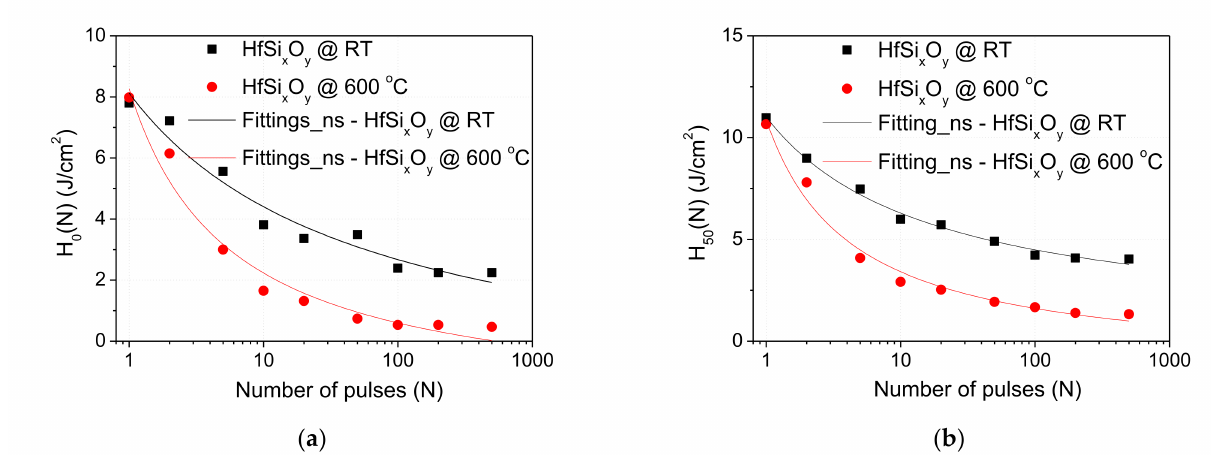
Figure 8. Threshold energy densities relative to the number of laser pulses applied per site for hafnium silicate samples. ( a ) H 0 (N)—threshold energy density for 0% damage probability and ( b ) H 50 (N)—threshold energy density for 50% damage probability.